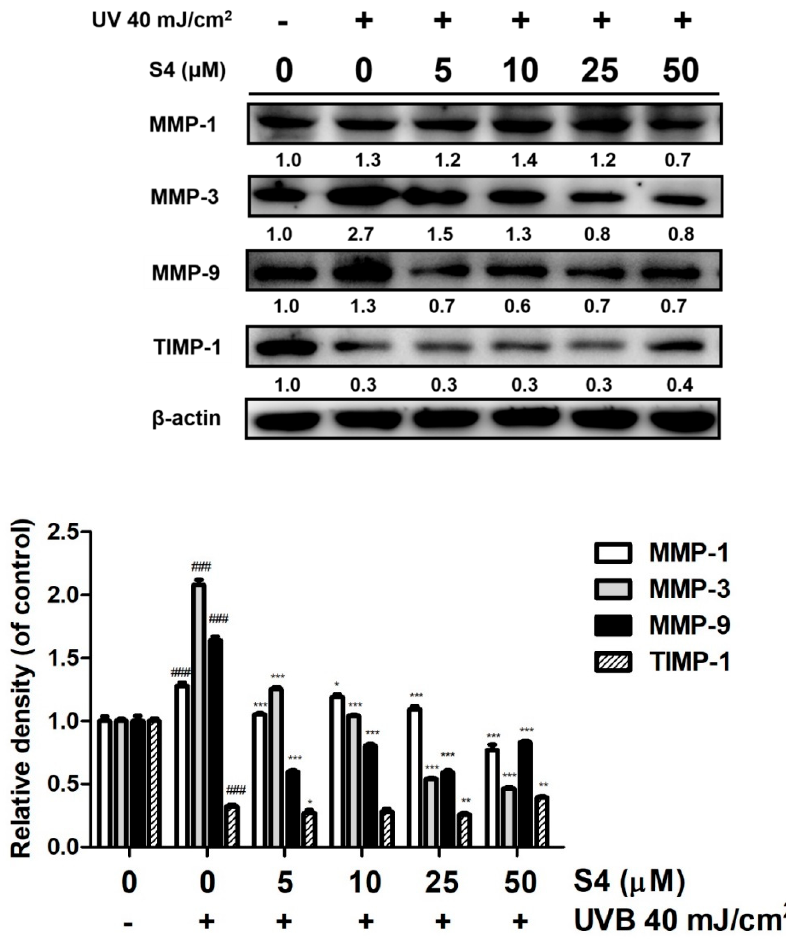
Figure 3. E ff ect of S4 on UVB-induced matrix metalloproteinases (MMPs) and tissue inhibitors of metalloproteinase (TIMP)-1 expression in human skin fibroblasts. The results were given as mean ± standard deviation ( n = 3). Significant di ff erence versus non-irradiation group: ###, p < 0.001. Significant di ff erence versus non-treatment group: **, p < 0.01; **, p < 0.01; ***, p < 0.001.